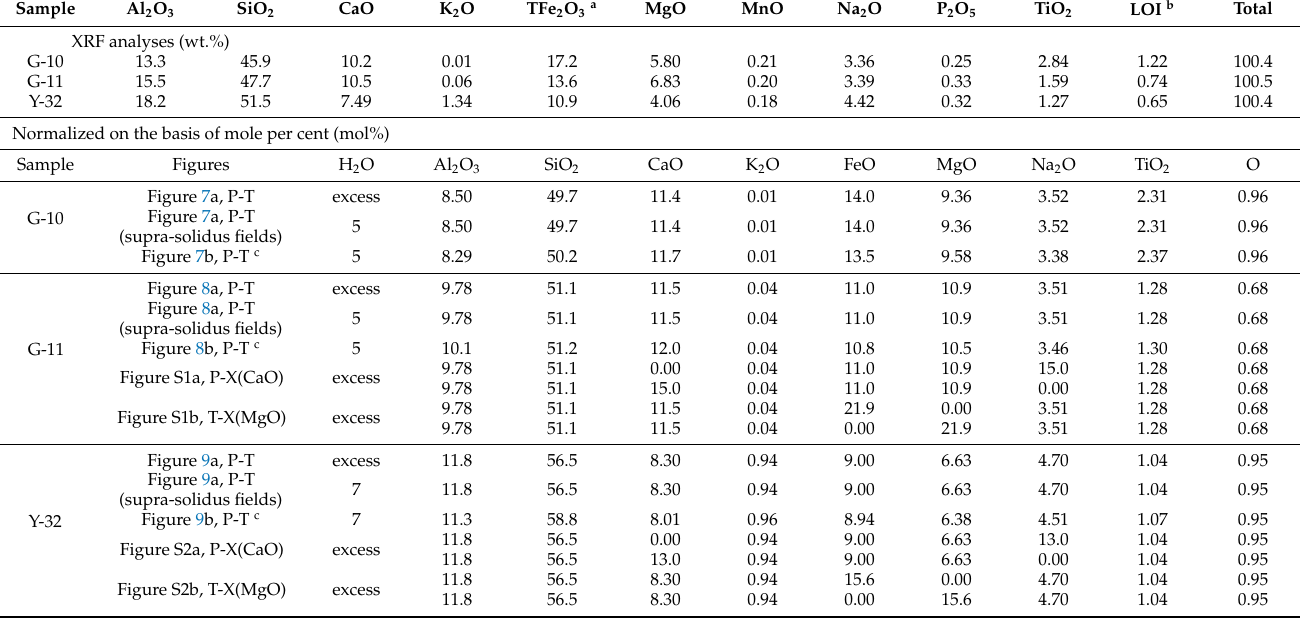
Table 1. Bulk-rock compositions (wt.%) of eclogites from the Guanshan and Yangkou area.